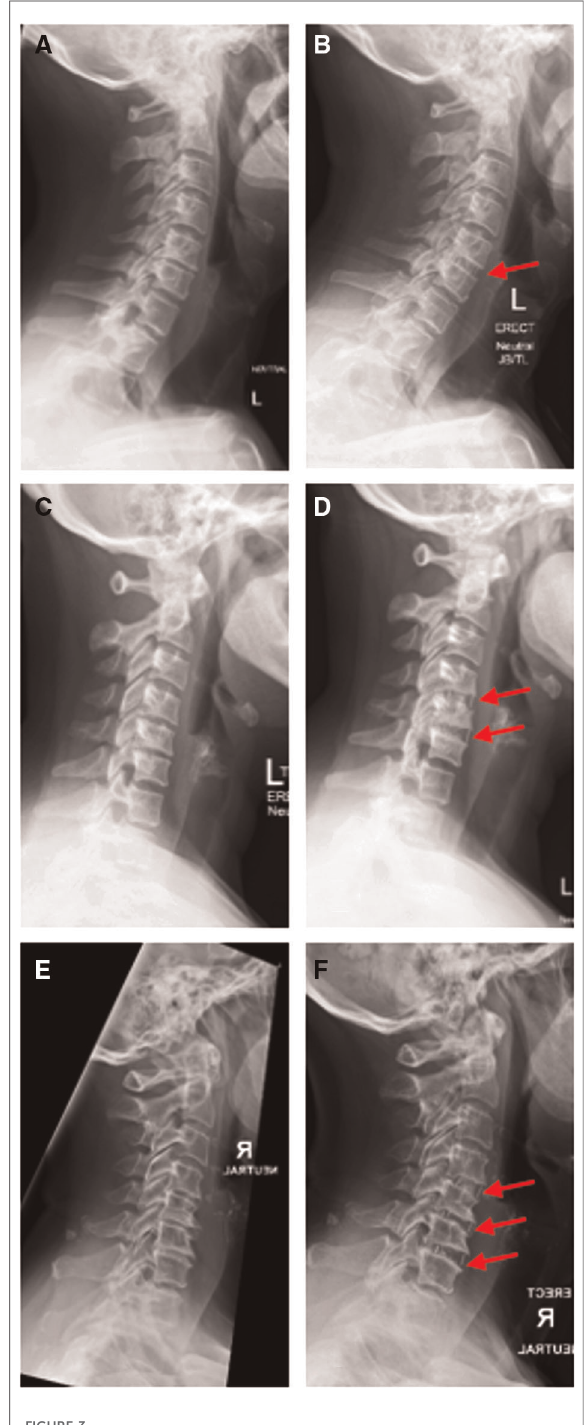
FIGURE 3 ( A,B ) Standing lateral x-ray of the true stand-alone cage for cervical degenerative disc disease in one-level (C5/6) preoperatively and at 2-year follow-up. ( C,D ) Standing lateral x-ray of the true stand- alone cage for cervical degenerative disc disease in two levels (C5/6 and C6/7) preoperatively and at 1-year follow-up. ( E,F ) Standing lateral x-ray of the true stand-alone cage for cervical degenerative disc disease of three levels (C4/5, C5/6, and C6/7) preoperatively and at 1-year